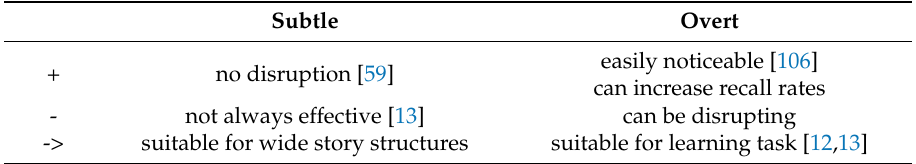
Table 8. Advantages and disadvantages of subtle and overt methods. The third row indicates for which requirements the methods are